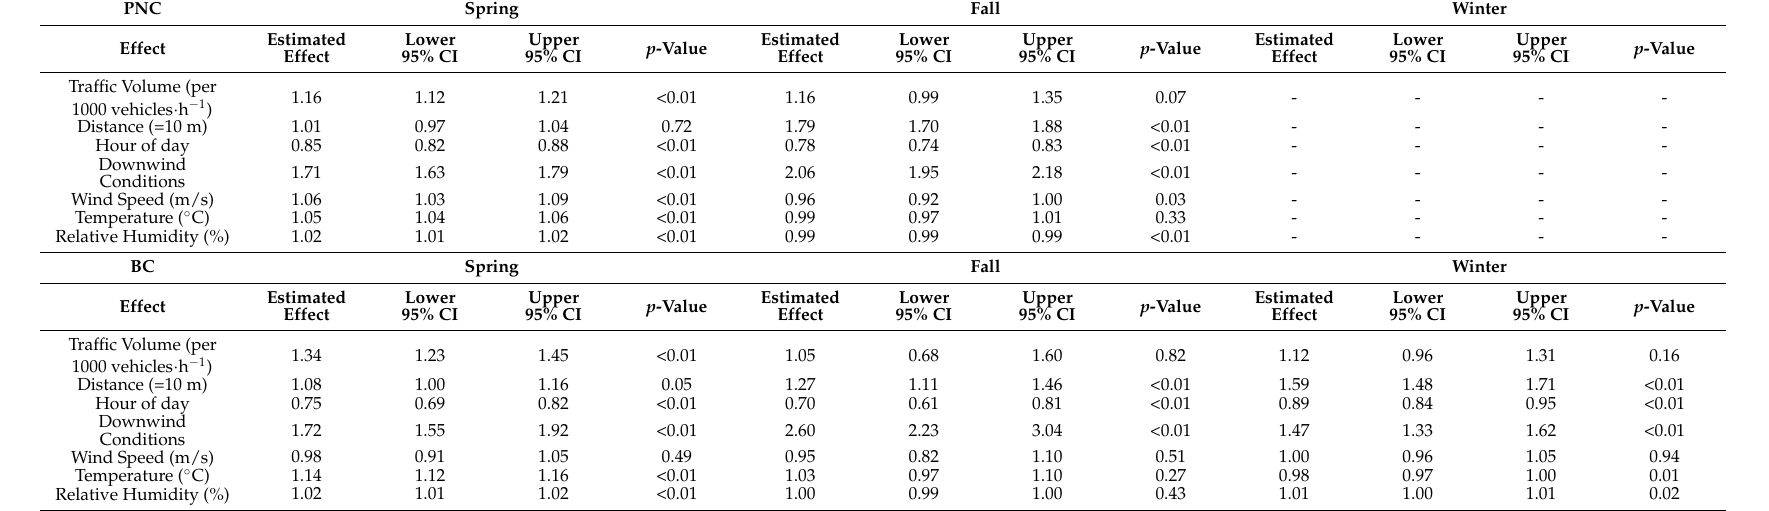
Table 4. Multivariable models of near-highway log-transformed particle number concentration (PNC) and black carbon (BC) concentration. PNC Spring Fall Winter Effect Estimated Effect Lower 95% CI Upper 95% CI p -Value Estimated Effect